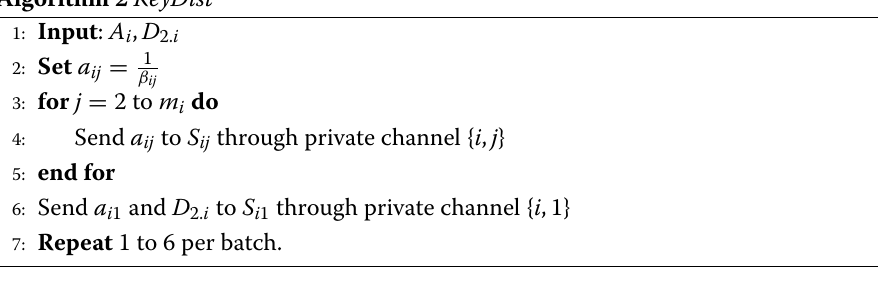
Algorithm 2 KeyDist